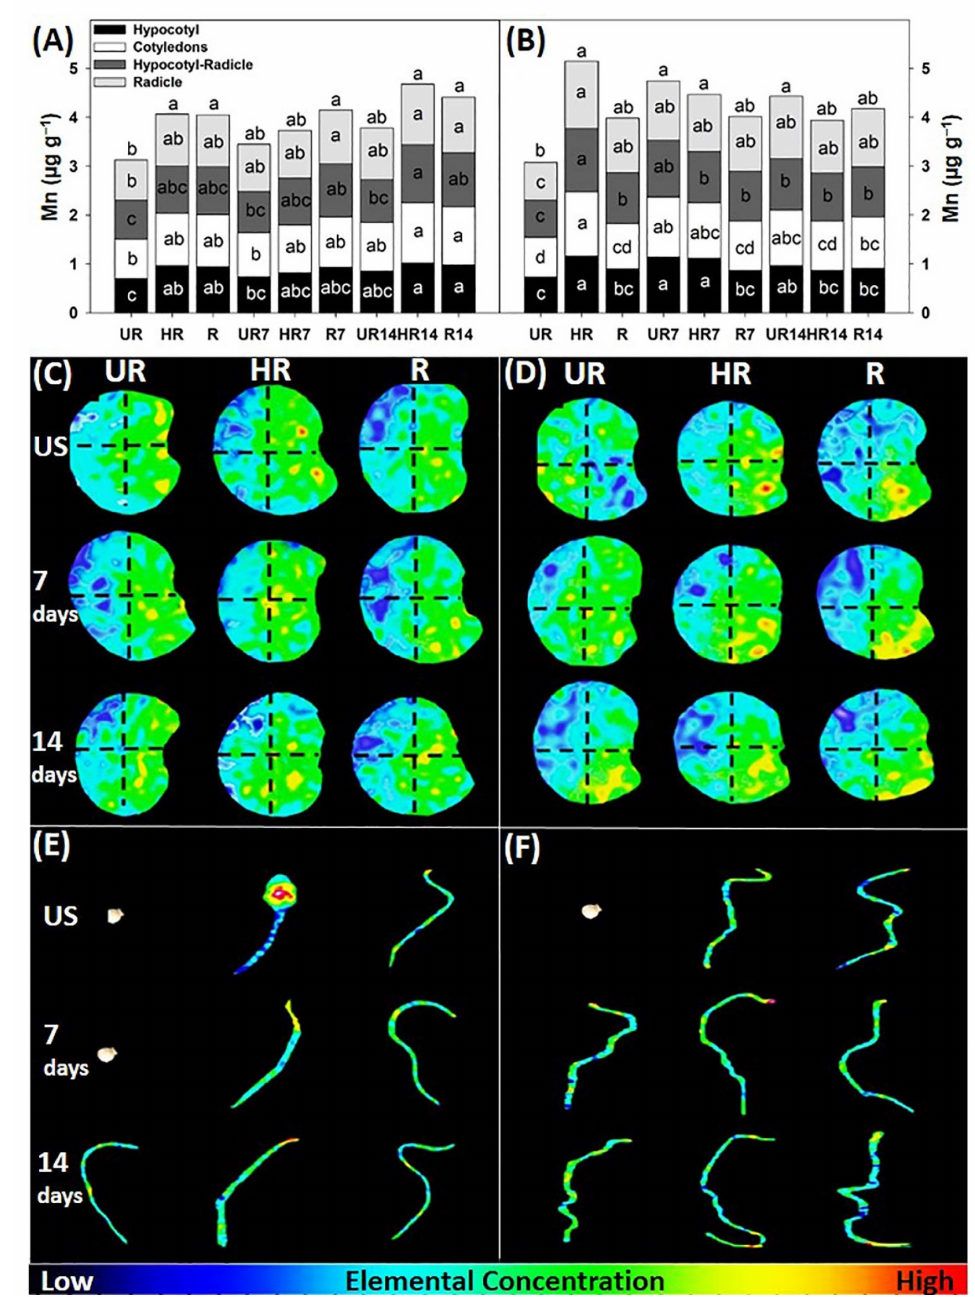
Figure 7. Mn concentration in seeds pre-imbibition ( A ) and post-imbibition ( B ), Mn distribution in habanero pepper seeds pre-imbibition ( C ) and post-imbibition ( D ), habanero seedlings at 10 ( E ) and 14 days ( F ) after sowing, of seeds of unripe (UR), half-ripe (HR), and ripe (R) fruits; unstored (US) and stored for 7 and 14 days postharvest. Colors in panels ( C – F ) are based on a relative intensity scale (reported at the bottom of the figure) generated on the intensity of the X-ray fluorescence K α peak of Mn in the samples. Data are means. Different letters indicate statistically significant differences among treatments (Duncan, p ≤ 0.05, n =